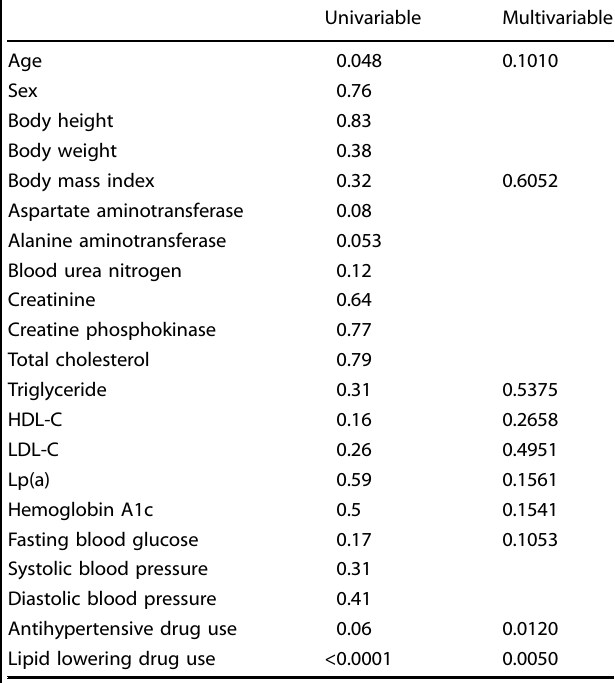
Table 1. The p value of univariate and multivariate analyses for associations between coronary artery calcium score and each data ( n =